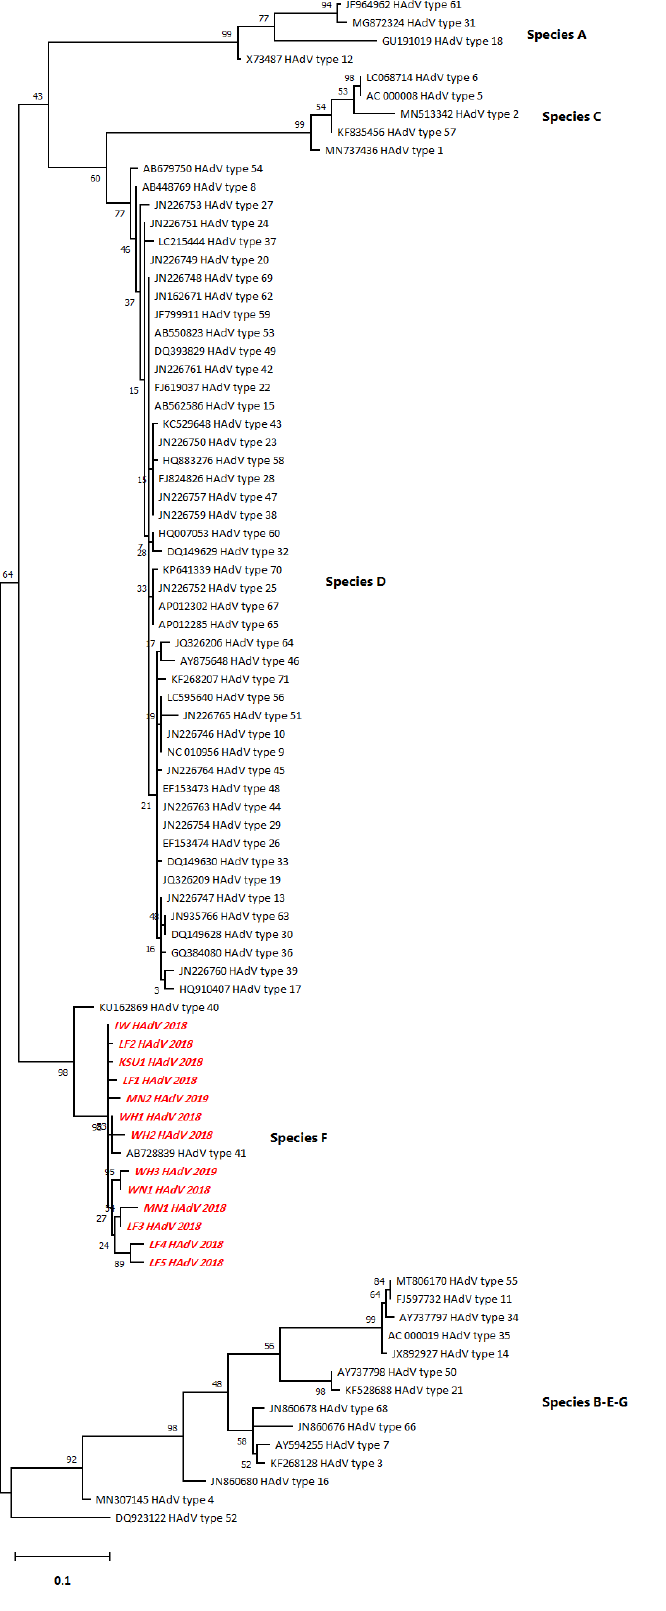
Figure 2. The phylogenetic tree for the HAdV hexon sequences constructed by the maximum likelihood method and Tamura 3-parameter model.